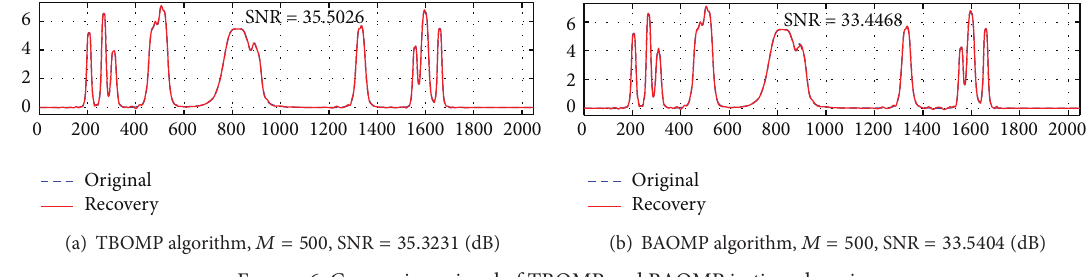
Figure 6: Comparison signal of TBOMP and BAOMP in time domain.